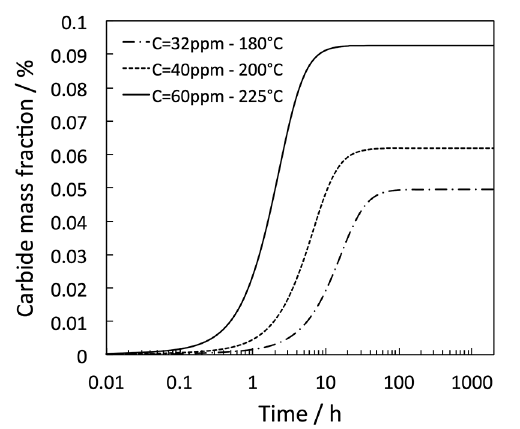
Figure 6. Carbide mass fraction evolution for samples with 32, 40 and 60ppm aged at 180, 200 and 225°C, respectively.